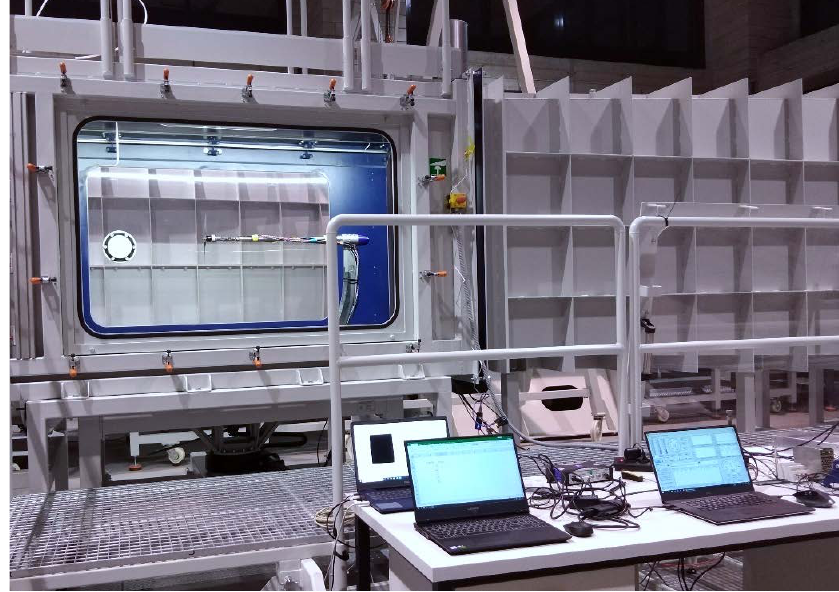
Figure 3. General view of the test stand for propellers.